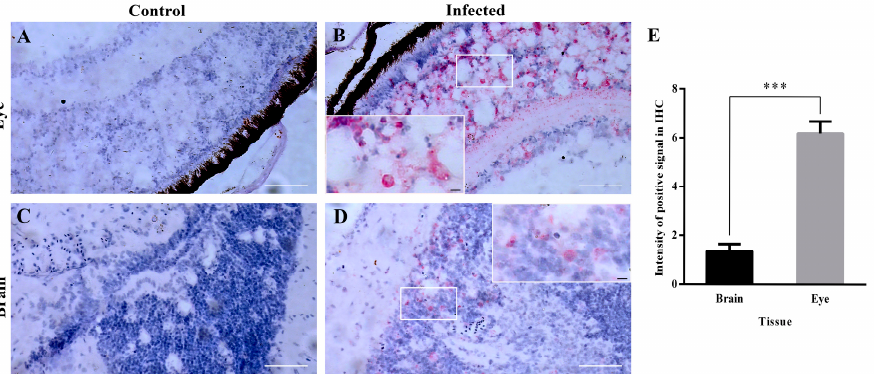
Figure 7. IHC detects and characterizes B2 protein expression in eye and brain tissues of grouper 3 d post-infection. ( A ) Healthy eye tissue; ( B ) NNV-infected eye tissue; ( C ) Healthy brain tissue; ( D ) NNV-infected brain tissue. Scale bar = 50 μ m. ( E ) The intensity of positive signals in eye and brain. The data were processed by image J 1.51k. *** p < 0.001.